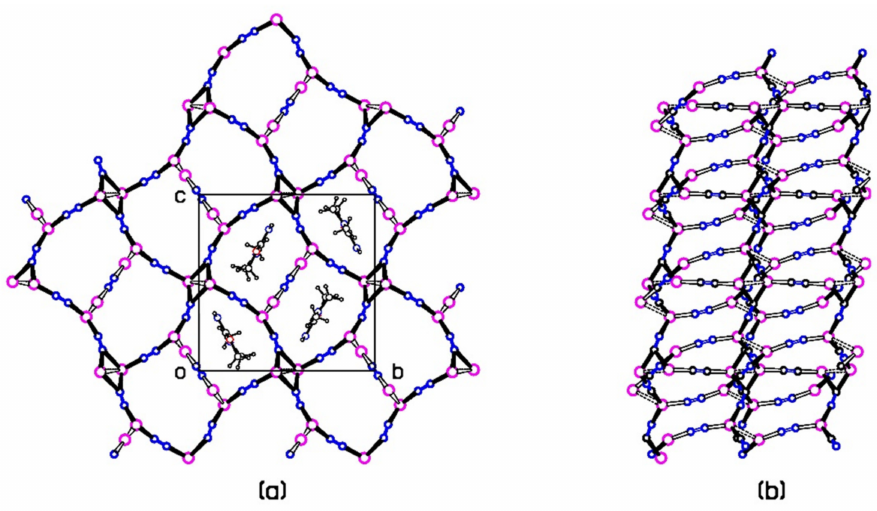
Figure 4. CuCN network and packing. ( a ) View down a-axis, showing the belted 24-membered rings. Oxazolidin cations shown only in the unit cell outline. ( b ) View down b-axis, showing the rings edge on linked by cyanide groups into the 3D structure. Cell outline is not included in this view. Magenta: Cu; red: O; blue: N; black: C or